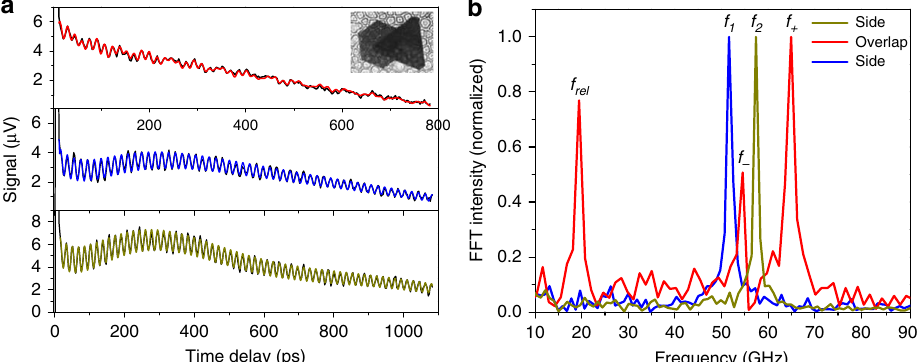
Fig. 3 Strong vibrational coupling for stacked Au nanoplates. a Transient absorption traces for stacked Au nanoplates probing on each single nanoplate and the overlapping area. The color lines are the fi tting curves to the experimental data. The inset shows an optical image of the stacked Au nanoplates on carbon fi lm. b Fast Fourier transform (FFT) spectra of the mechanical vibrations of the fi rst plate f 1 , second plate f 2 , and the overlapping area. Mechanical coupling between the plates creates new frequencies f + and f − . The vibration at ~20 GHz was ascribed to a mode that corresponds to motion of the two nanoplates relative to each other